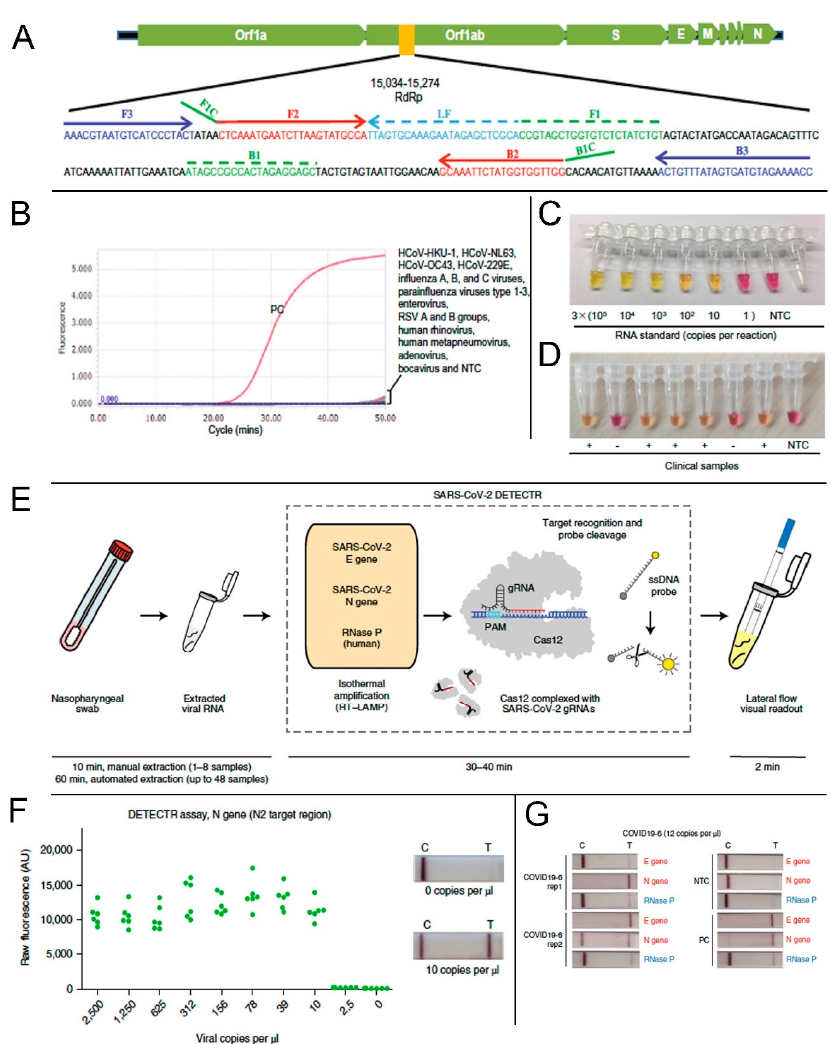
Figure 4. Application of reverse transcription loop-mediated isothermal amplification (RT-LAMP) method for the detection of SARS-CoV-2. ( A ) Location of RdRp primer sequence in the SARS-CoV-2 genome. ( B ) Cross-reactivity test of the novel SARS-CoV-2 RT-LAMP assay to other common respiratory viruses. Viral RNA isolated from a COVID-19 positive patient was used as a positive control (PC). NTC, non-template control. ( C ) RT-LAMP based colorimetric visual detection of SARS-CoV-2 RNA standards. ( D ) Clinical samples from positive ( + ) or negative ( − ) COVID-19 cases. NTC: non-template control. ( E ) Schematic representation of the SARS-CoV-2 DETECTR method workflow such as RNA extraction. The DETECTR method that involves the LAMP preamplification, and Cas12-based gene detection, and visualization by a fluorescent reader or lateral flow strip (TwistDx). (F) LoD for DETECTR assay showing the fluorescence values using SARS-CoV-2 DETECTR assay ( n = 6) using